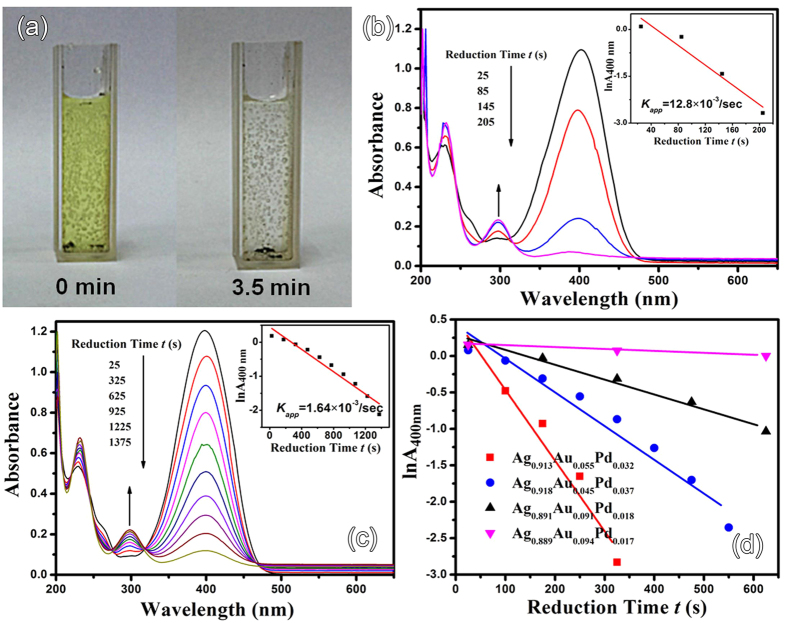
Photographs showing the color change of the 4-NP solution after reaction for 3.5 min under addition of Ag0.90Au0.078Pd0.022 networks (a) UV-Vis absorption spectra of 4-NP during reduction by NaBH4 in the presence of 0.5 mg of (b) Ag0.90Au0.078Pd0.022 and (c) precursor Ag sponge. The inset shows the logarithm of the absorbance at 400 nm vs. reduction time t. (d) Plots of lnA400nm versus t for different Ag-Au-Pd networks.